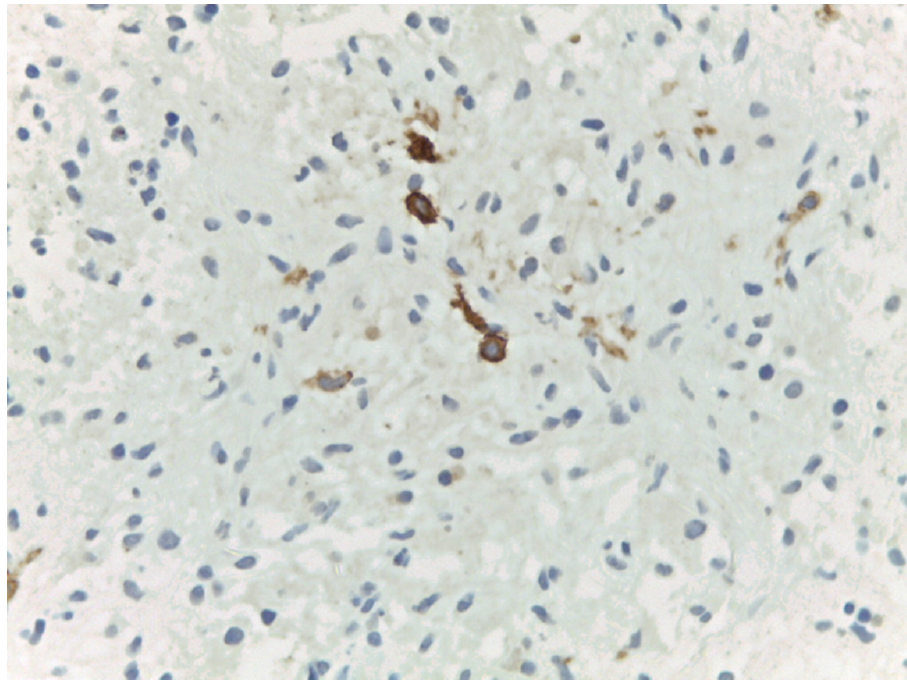
Figure 6. Rosai–Dorfman disease of the breast: immunohistochemistry—CD1a positive histiocytes (40×).